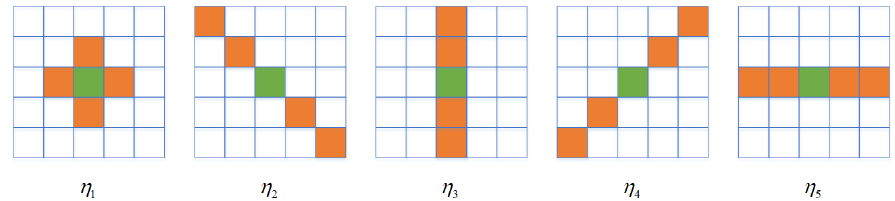
Figure 1. Five neighborhoods in the AN